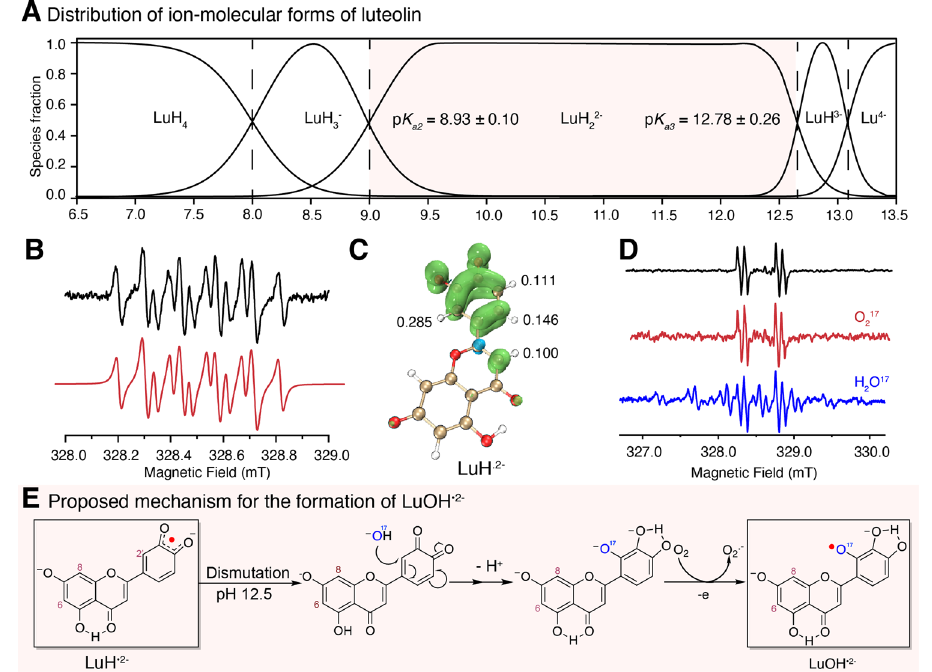
Fig. 6 | pK a pro fi le of luteolin and the radicals generated. A The distribution curve of luteolin species in aqueous solution LuH 4 : luteolin, LuH 3 − : monoanion, LuH 2 2 − : dianion, LuH 3 − : trianion, and Lu 4 − : tetraanion. B Experimental (black)